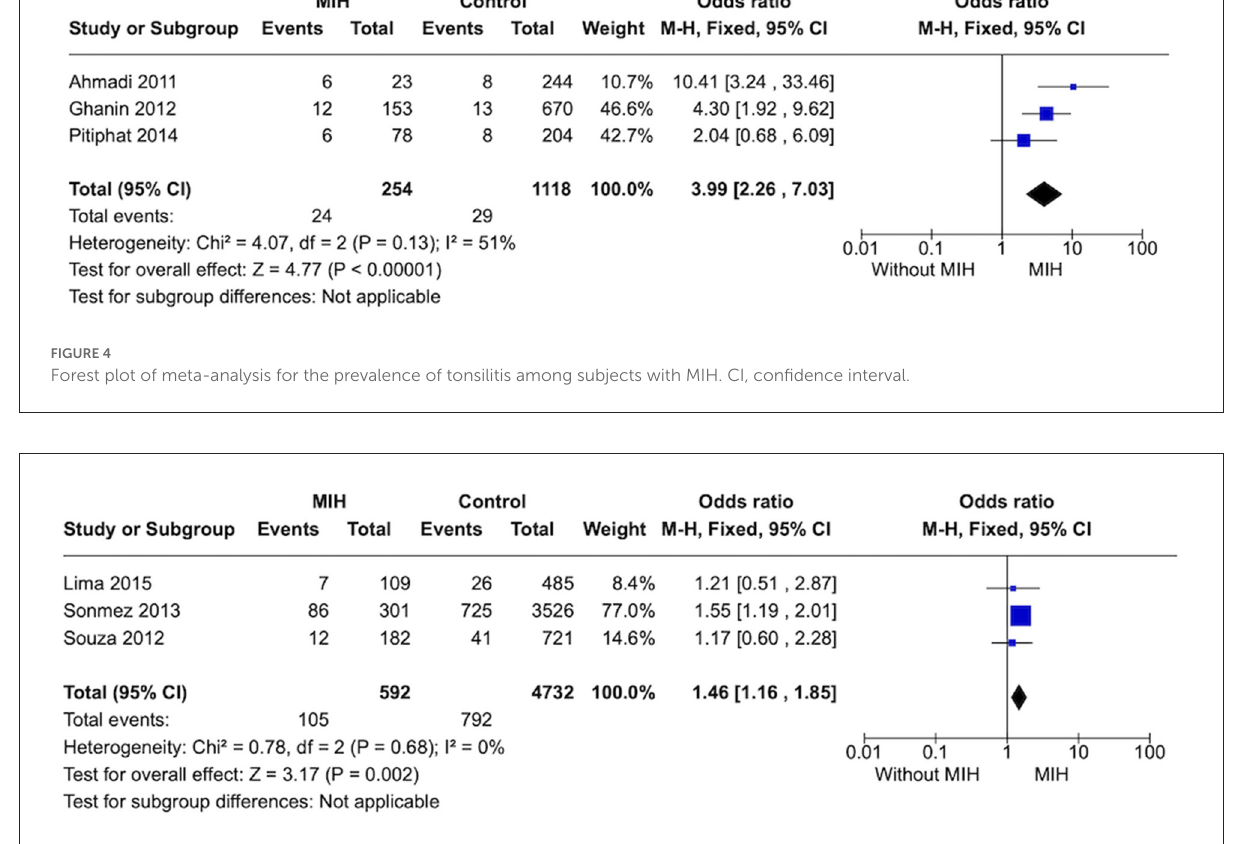
FIGURE5 Forest plot of meta-analysis for the prevalence of bronchitis among subjects with MIH. CI, confidence interval.